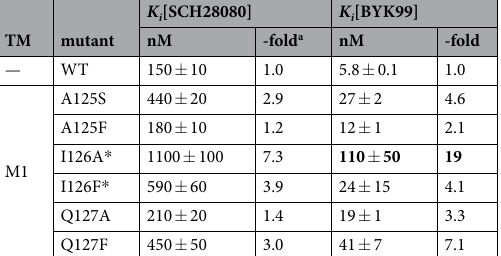
Table 2. Effect of mutation in the M1 helix on H + ,K + -ATPase. Data are shown as in Table 1. Asterisks indicate mutants exhibiting high H + -ATPase activity, whose K i was determined by a K m / V max plot (see Materials and Methods for details).